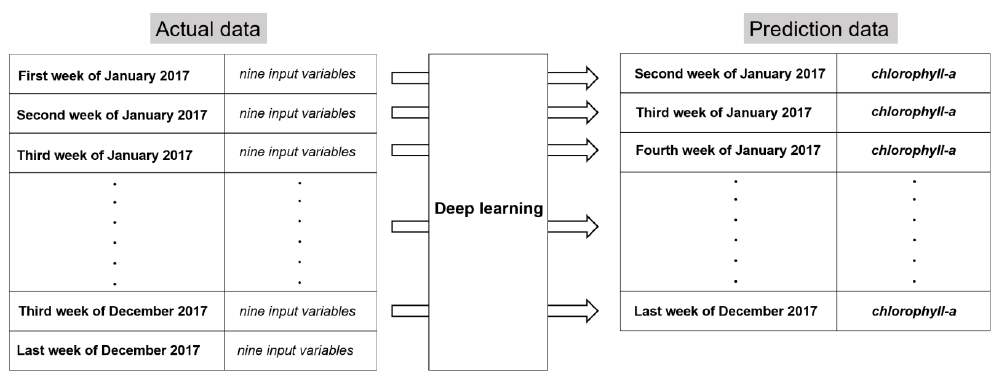
Figure 2. The deep learning model structure using nine input variables, three hidden layers, and one output layer (all fully connected).